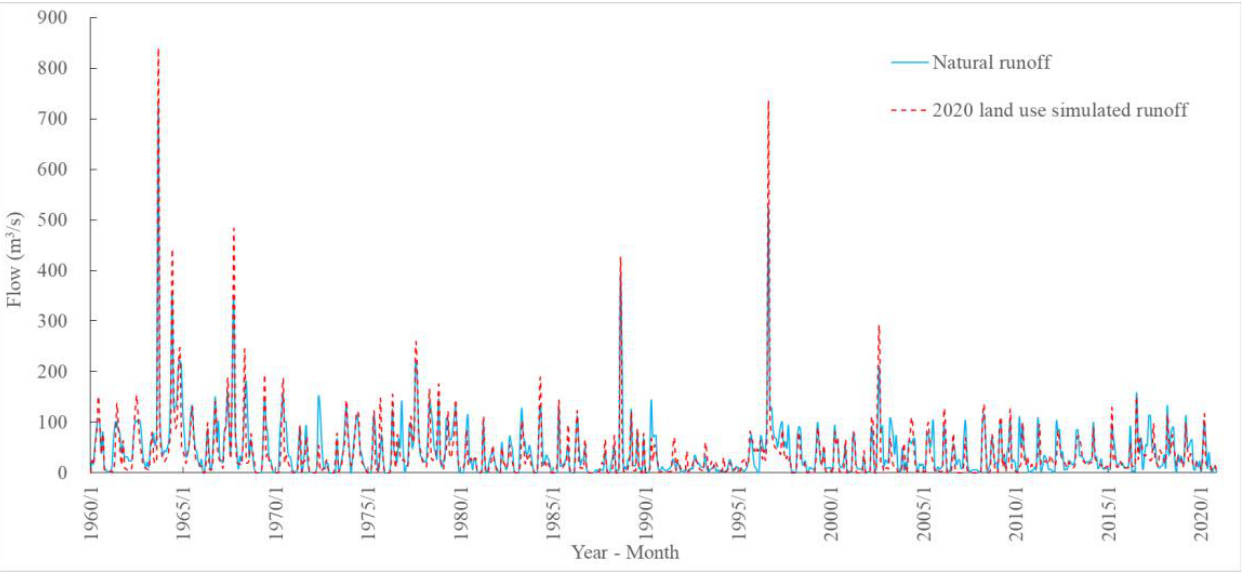
Figure 7. Comparison of simulated and natural runoff under the land-use scenario of 2020 at the Huangbizhuang Station.